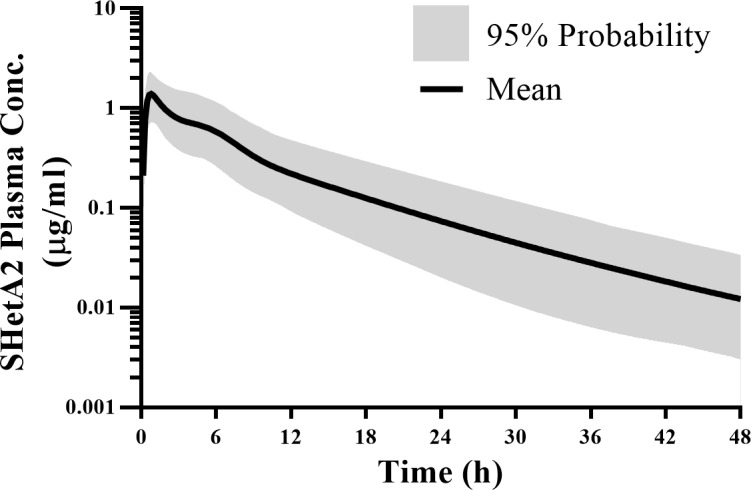
Simulated human PK profile of SHetA2 at 10 mg/kg obtained from 100 virtual subjects in the population simulator of GastroPlus with a two-compartment PK model with physiologically-based gut absorption model for humans.The solid line shows the mean concentrations and the shaded portion shows the 90% probability contour for the spread of concentrations around the mean.